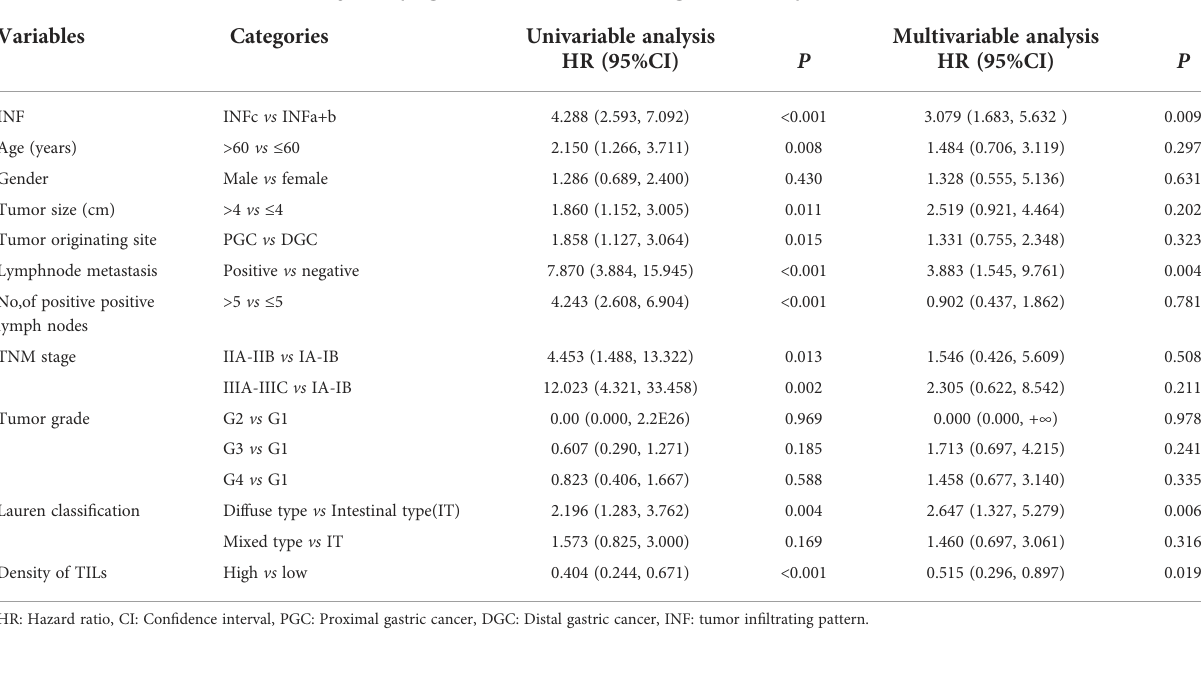
TABLE 3 Univariate and multivariate analyses of prognostic factors for survival of gastric cancer patients.